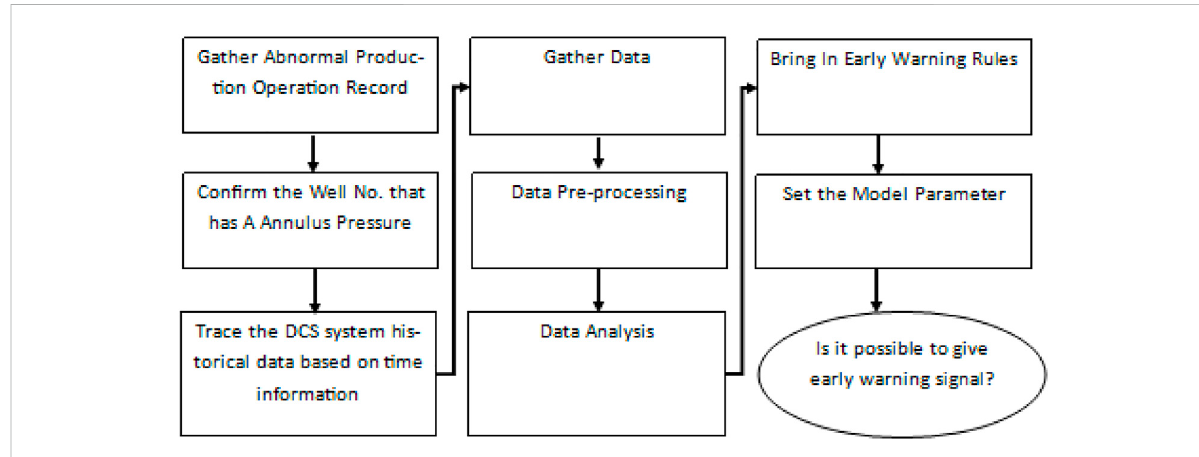
FIGURE 3 Early warning rule veri fi cation and analysis work fl ow.